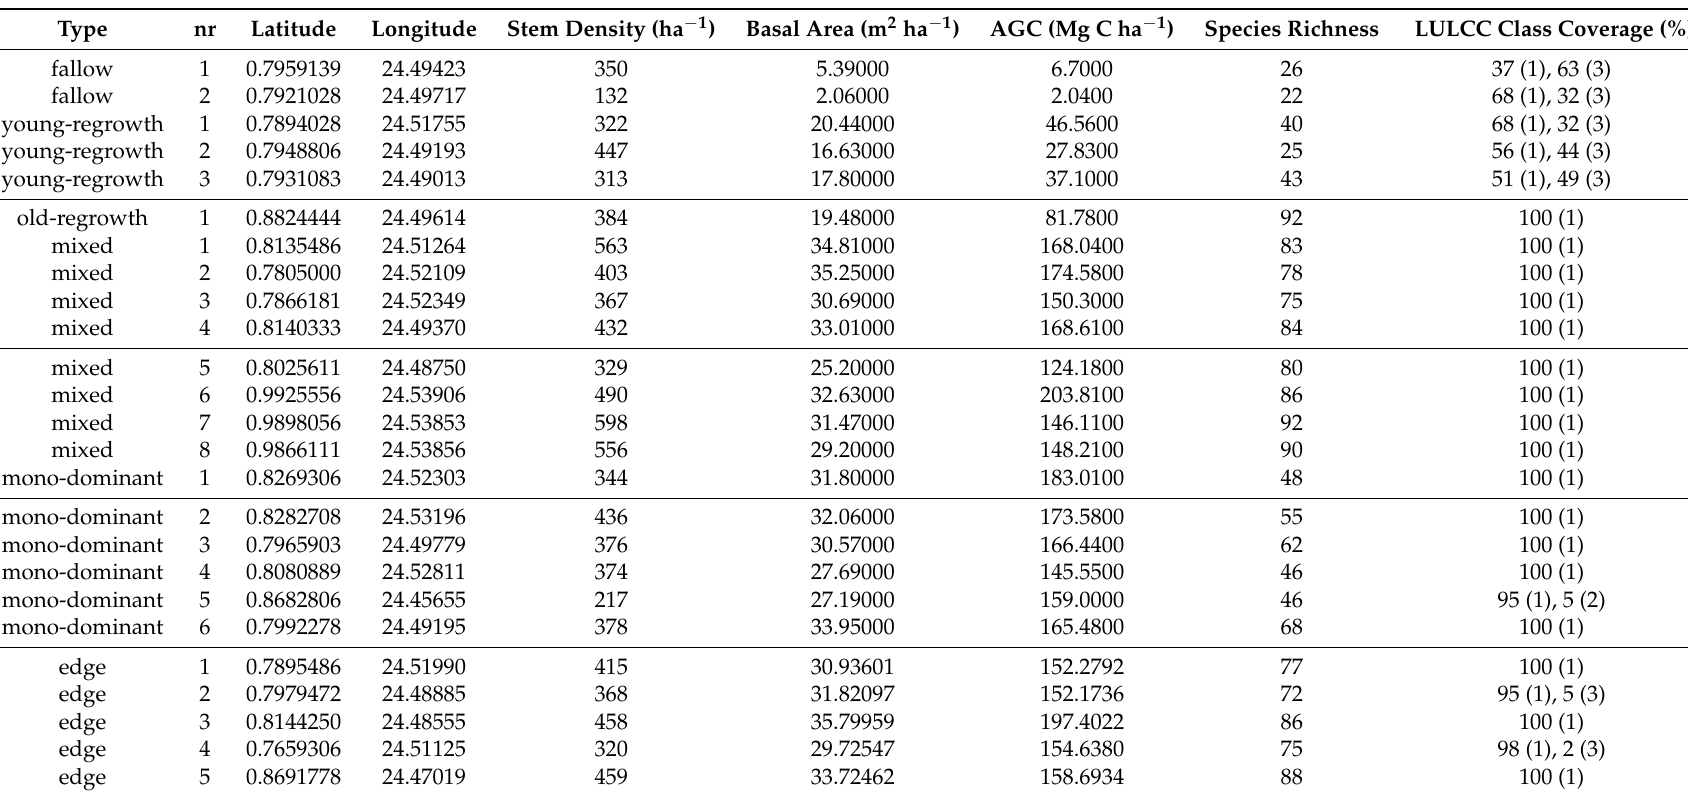
Table A2. Site description of all the current permanent sampling plots in the greater Yangambi region. We list the forest type, plot number, geographic location (in decimal degrees), stem density, basal area Above Ground Carbon (AGC), species richness and Land-Use and Land-Cover Change (LULCC) classes in a radius of 100 m around each plot